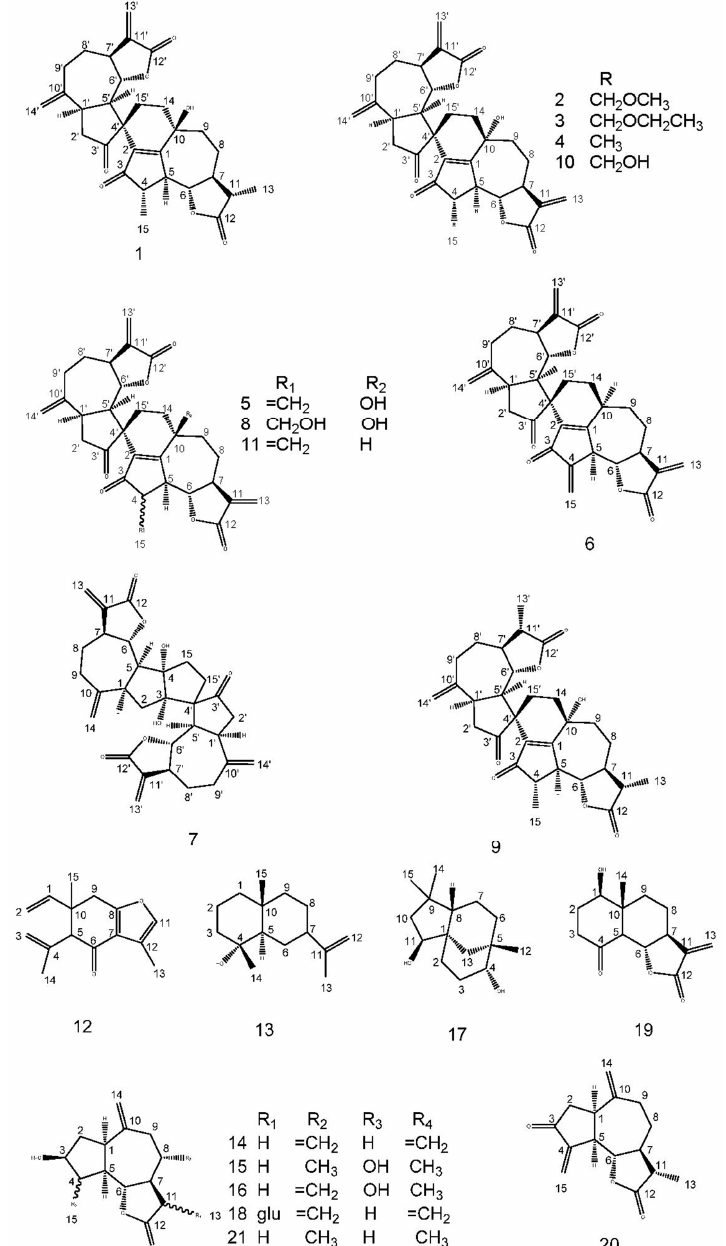
Figure 1. Structures of Compounds 1 – 21 .